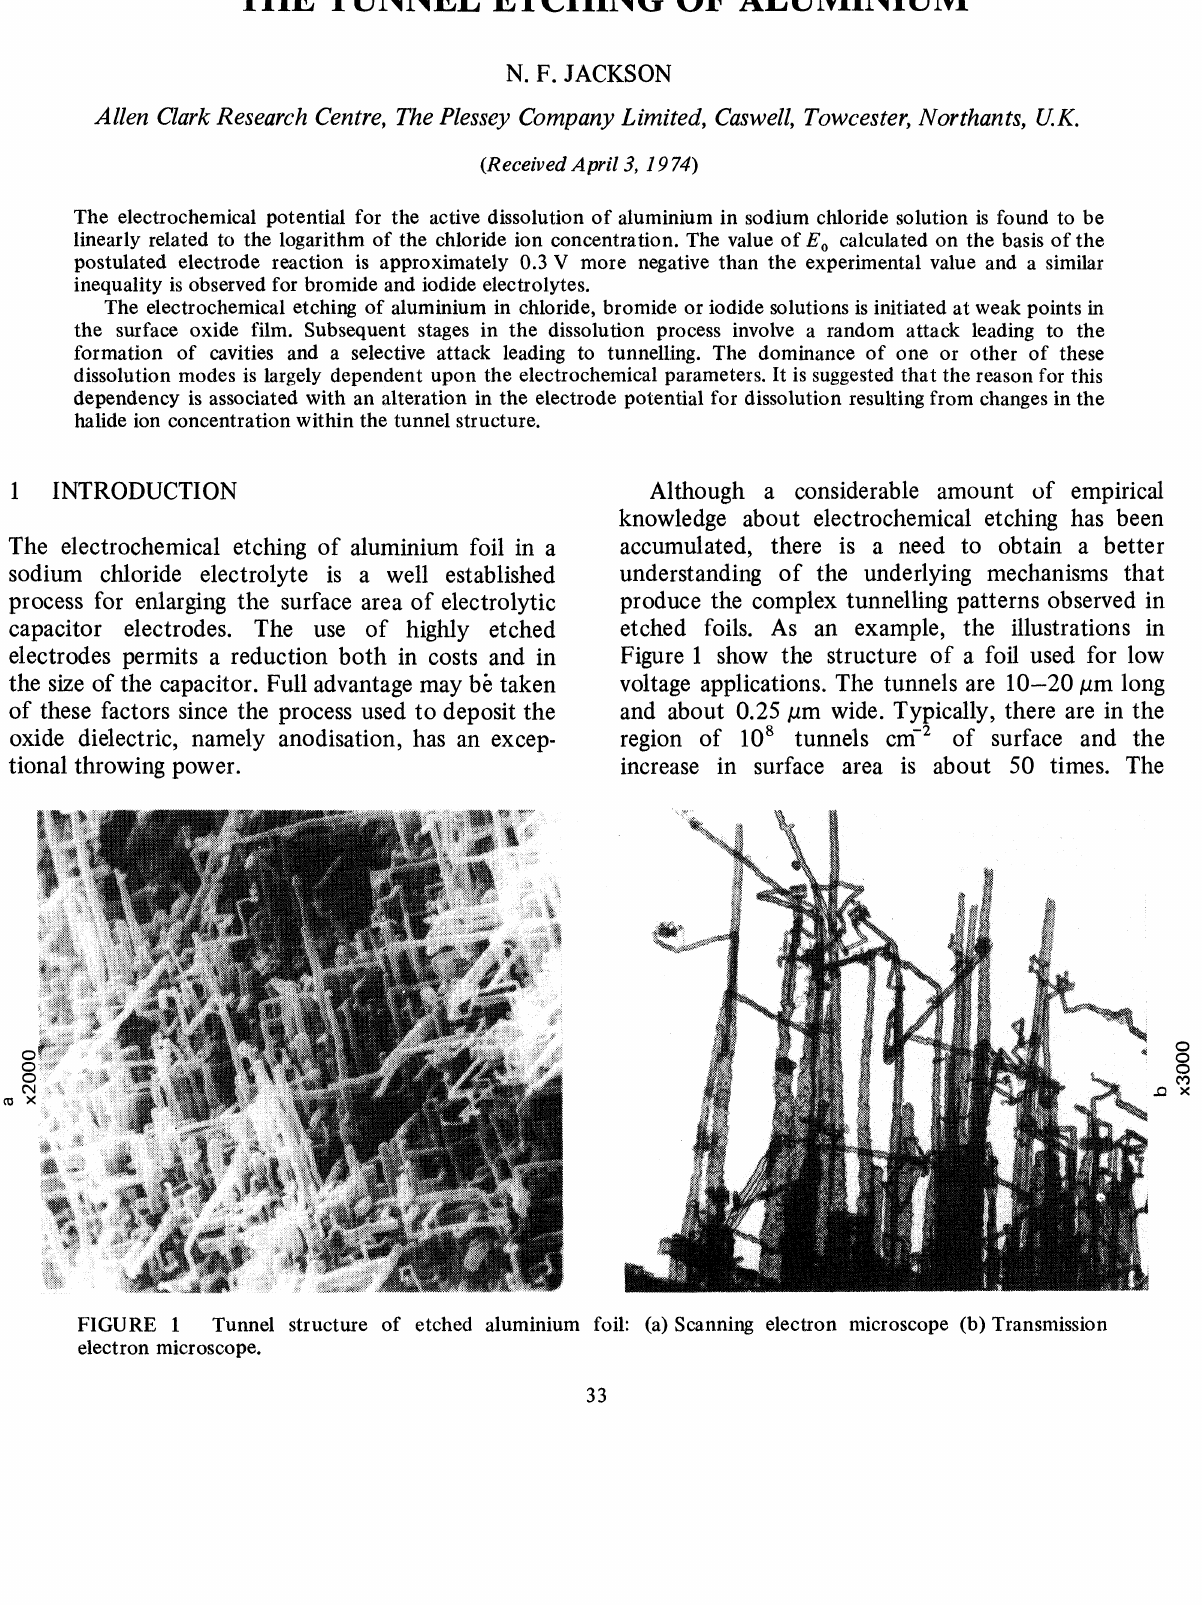
FIGURE Tunnel structure of etched aluminium foil: (a) Scanning electron microscope (b) Transmission electron